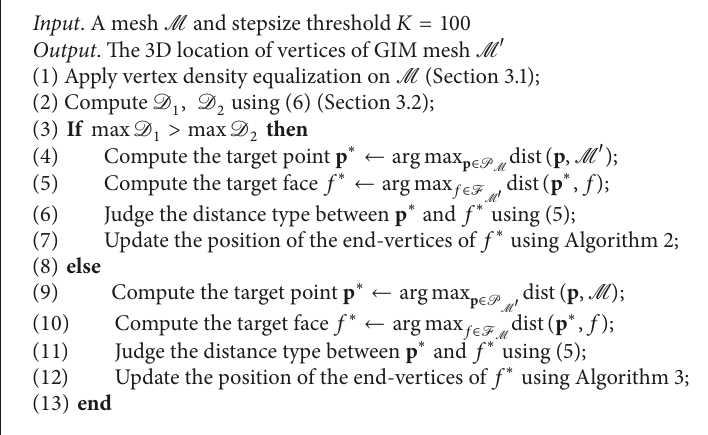
Algorithm 1: Optimal Hausdorff error driven geometry